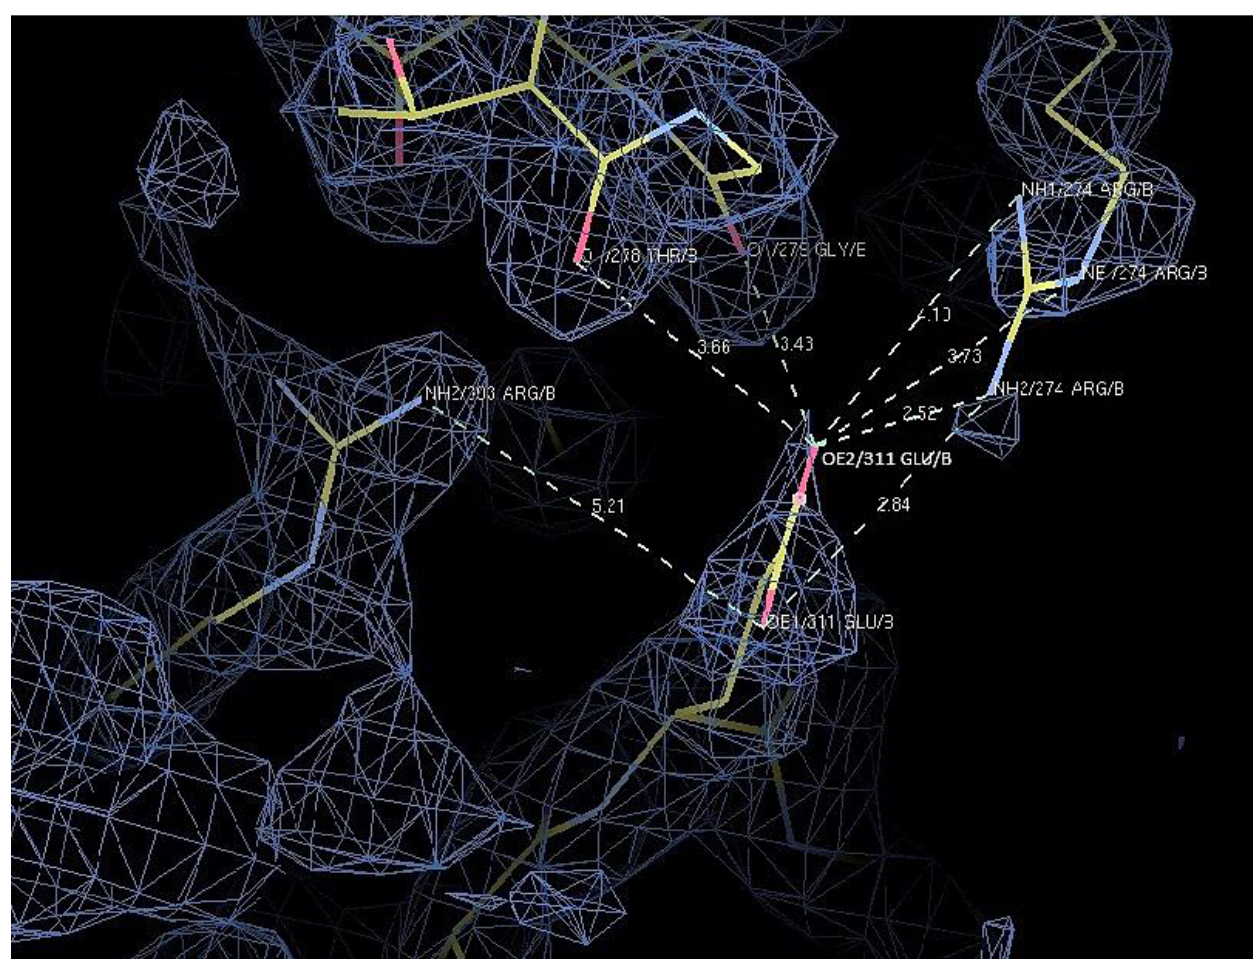
Figure 9. Snapshoot of ion pair interaction formation of D311E lipase crystal structure at residue between Glu311 and four residues (Arg 274, Thr 278, Gly 279 and Arg 303).